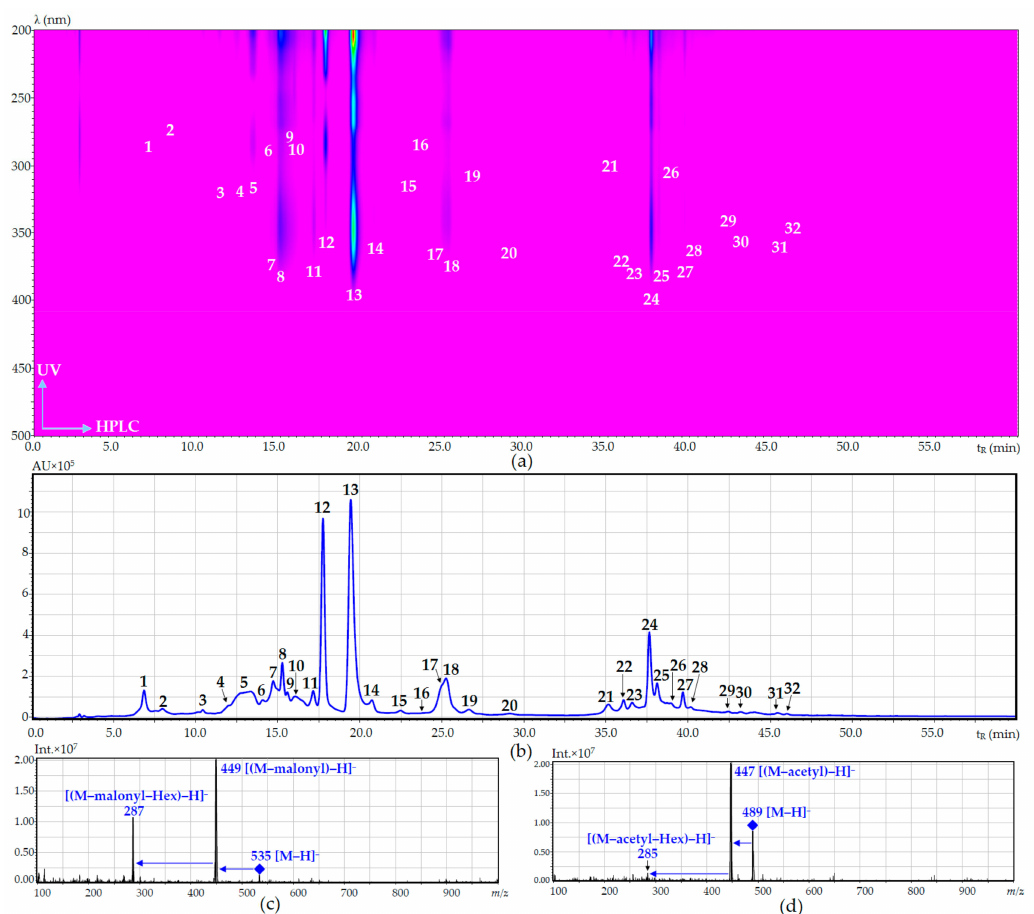
Figure 1. HPLC-UV map ( a ); and RP-HPLC-DAD chromatogram at 280 nm ( b ) of low-temperature sample of D. palmatum herb; ESI-MS spectra of unknown compounds 6 (eriodictyol- O - malonyl-hexoside) and 20 (luteolin- O -acetyl-hexoside) presented at ( c , d ), respectively. The numbers in the Figure 1a,b correspond to the compounds indicated in Table 4. AU, absorbance units; Int., signal intensity.